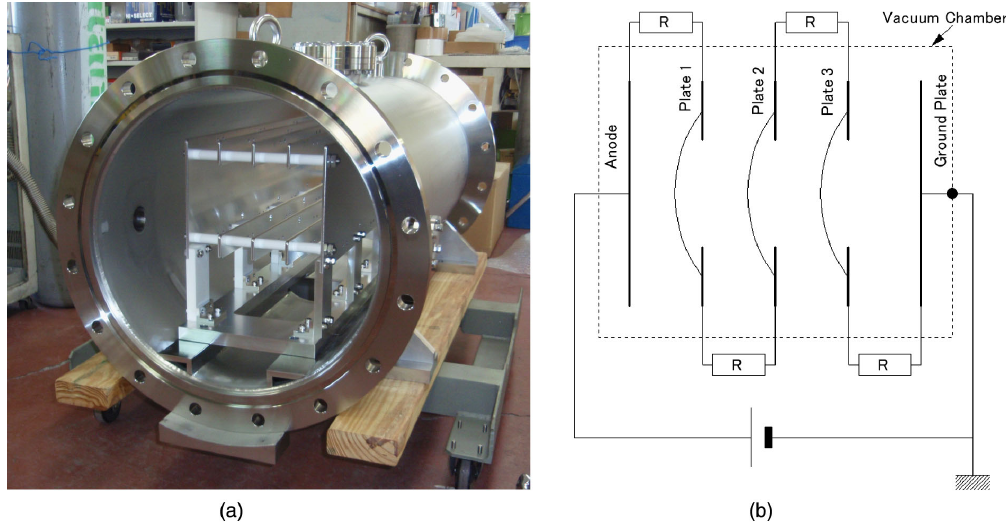
FIG. 10. (a) Photograph of the ES-Kicker. (b) Schematic view of a dividing resistor